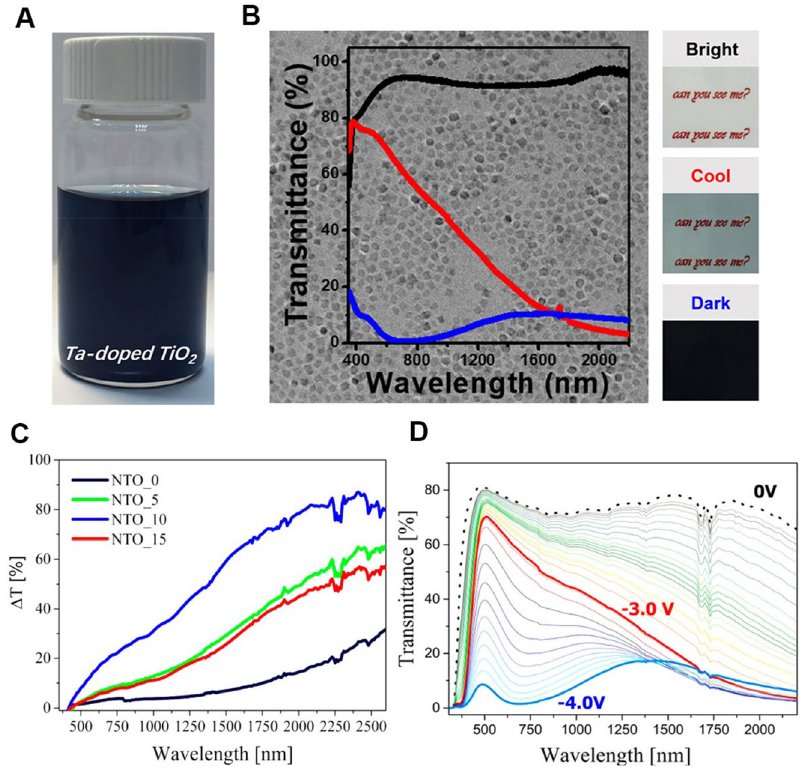
Figure 10: Structure and characterization of TiO 2 -based electrochromic fi